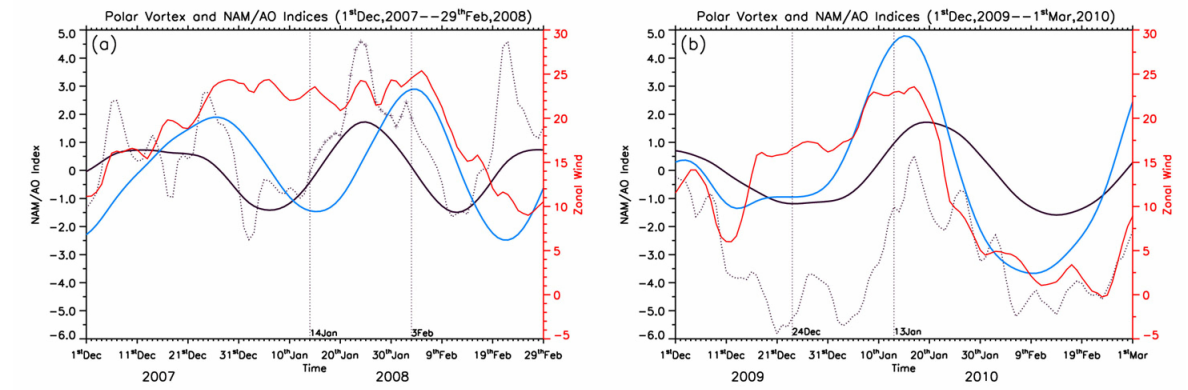
Figure 8. ( a ) The Polar Vortex and AO/NAM indices of the 2007/08 winter. The left vertical axes represent the AO/NAM index and the 30–60 band pass of the zonal wind. The right vertical axes represent the zonal wind. The horizontal axes depict the data. The black short-dotted line represents the AO/NAM index, and the black line represents its 30- to 60-day band pass. The red line represents the polar vortex index, and the blue line represents its band pass of 30–60 days. The period from 14 January to 3 February 2008, is the positive AO/NAM event. ( b ) The Polar Vortex and AO/NAM indices of the 2009/10 winter. The period from 24 December 2009, to 13 January 2010 is the negative NAO event.